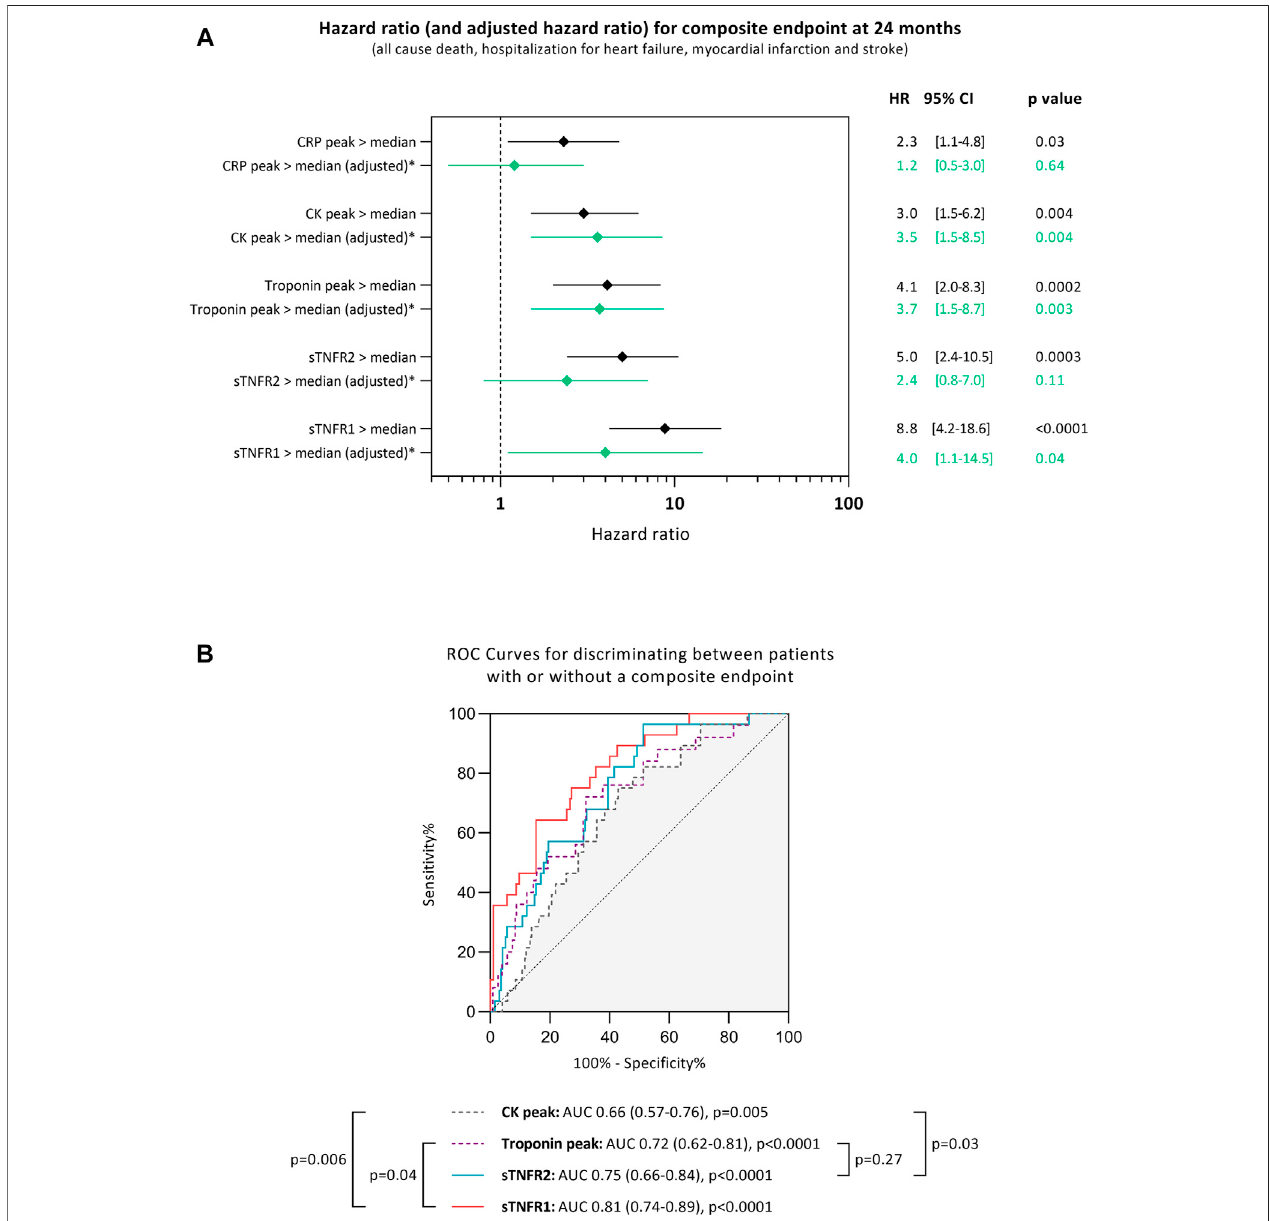
and high creatine kinase (CK) peak ( > median). The peak used is the maximum value of troponin, creatine kinase, or CRP measured for each patient individually (A) . Receiver-operating characteristic (ROC) curves for discriminating betweenpatientswith orwithoutacardiac adverse eventduring the 24months offollow-upafter STEMI according to different markers (B) . AUC: area under the curve, sTNFR1: soluble tumor necrosis factor receptor 1, and sTNFR2: soluble tumor necrosis factor receptor2.*HazardsratioadjustedinmultivariableCoxregressionanalyseswithmodelsincludingage,sex,diabetes,hypertension,smoking,renaldysfunction,troponin peak, TIMI fl ow grade after PCI, and high levels of sTNFR1 ( > median) or high levels of sTNFR2 ( >